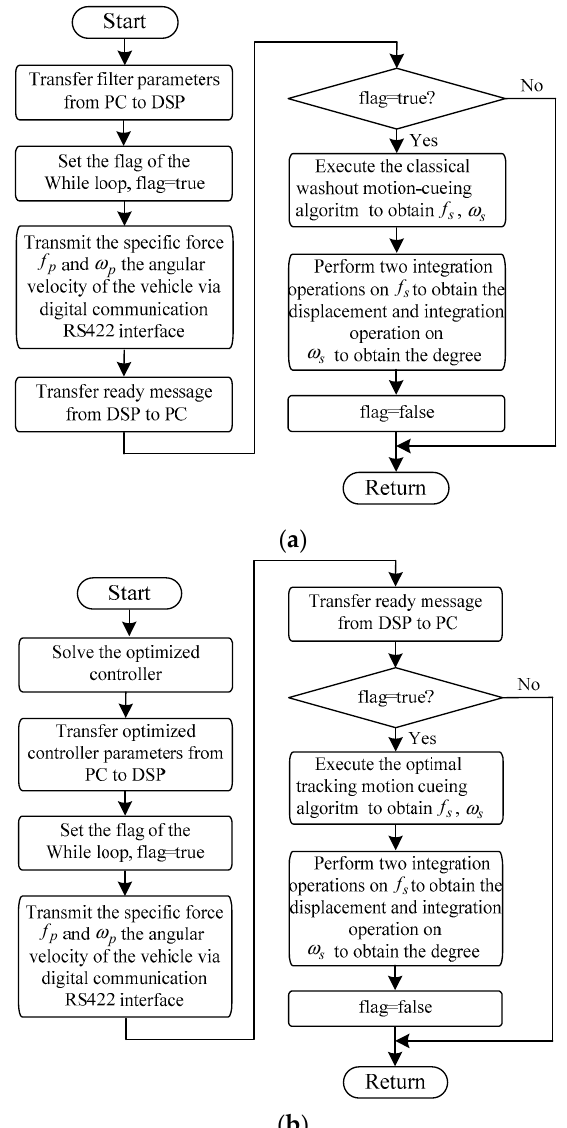
Figure 8. The flowchart of the DSP-based motion-cueing algorithms: ( a ) Classical washout algorithm; ( b ) Optimal control algorithm.